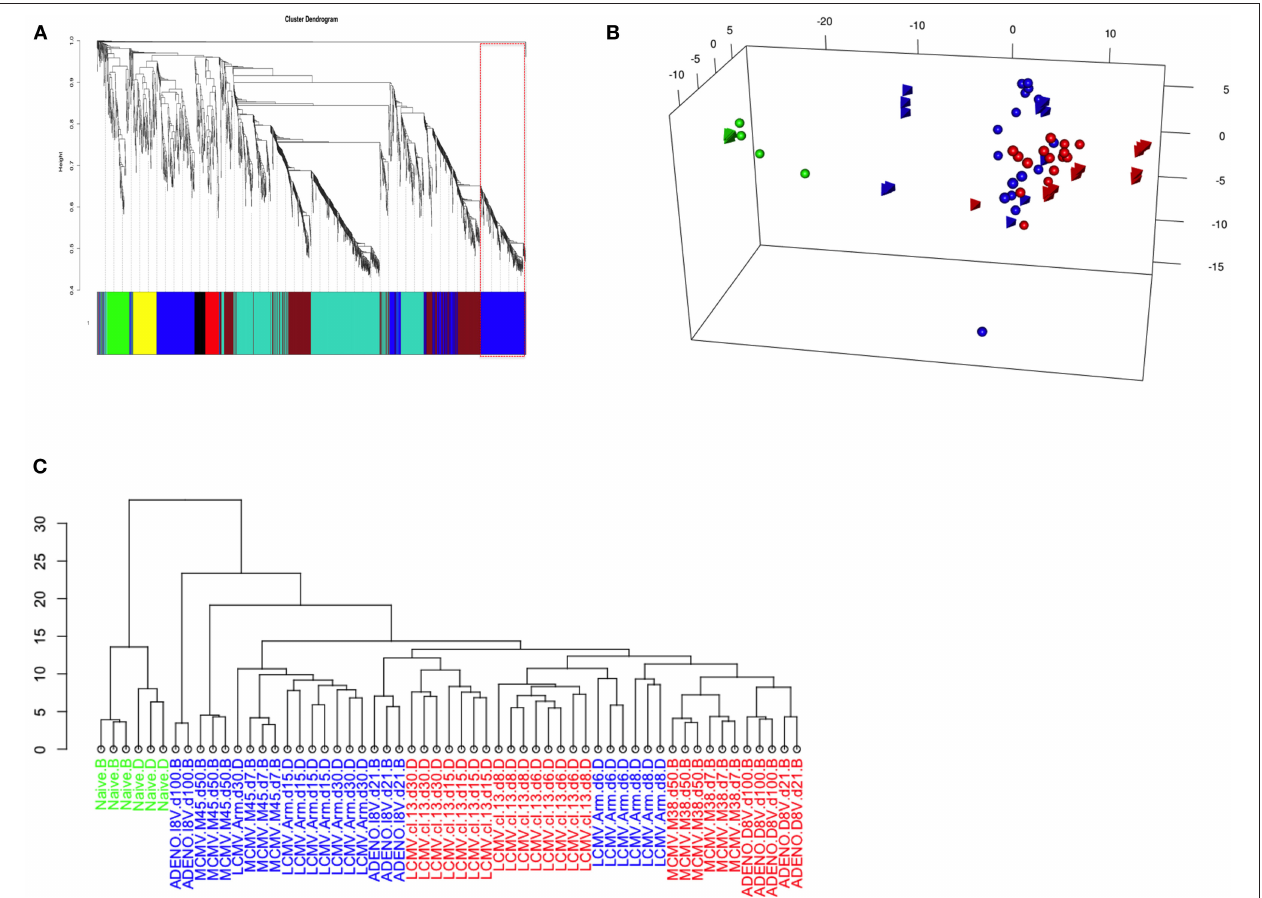
FIGURE 4 | (A) Weighted Gene Co-expression Network Analysis of Inflating samples. Gene co-expression network analysis detected 6 gene modules (merging distance = 0.25, soft-thresholding power β = 9); Blue module (highlighted) genes are enriched with immune relevant GO categories (Table S3A) and contains relevant genes such as Tbx21, Eomes, Zeb2, and E2f2 (Table S5A) . (B) PCA of Inflating/Exhausted samples based on Blue module genes. PCA plot using the first three principal components and based on a gene set of 588 genes, detected as blue module in Gene co-expression network analysis of Inflating samples only (Figure 3A) . The plot shows distribution of Naïve (green), Non-inflating and Non-exhausting (blue), and Inflating and Exhausting (red) samples (spheres: Exhaustion study; tetrahedron: Inflation study). (C) Hierarchical clustering of Inflating/Exhausted samples based on Blue module genes. Dendogram plot showing sample clustering analysis (Euclidian distance) on Inflating-Exhausted merged sets, based on a gene set of 469 genes, detected as blue module in a repeated Gene co-expression network analysis of Inflating samples after removing outliers (Soft-thresholding power β =